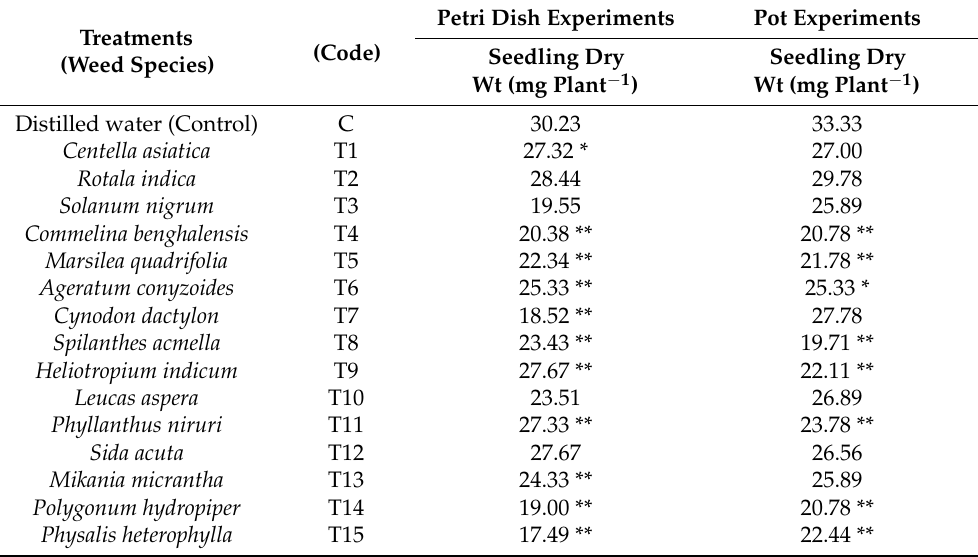
Table 5. Estimation of dry biomass of T. aestivum seedlings that treated with aqueous root exudates of weed species.